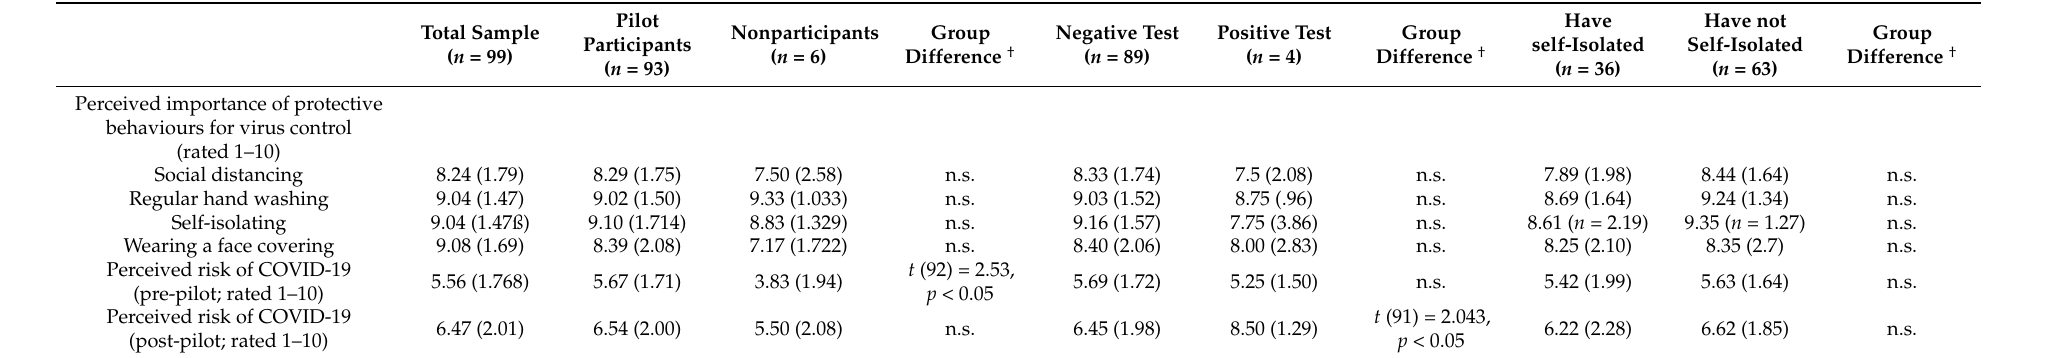
Table 11. Mean (standard deviation) of perceived risks and importance of health protective behaviours within and across study groups.